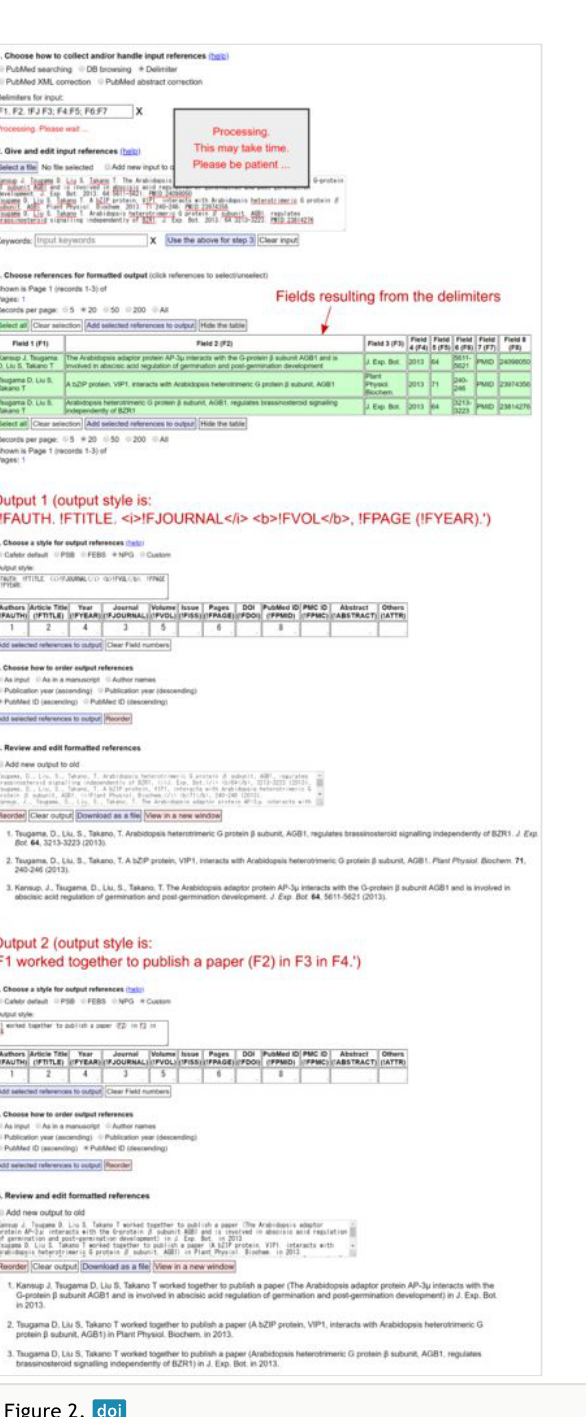
Figure 2. Example of use of the "Delimiter" option on